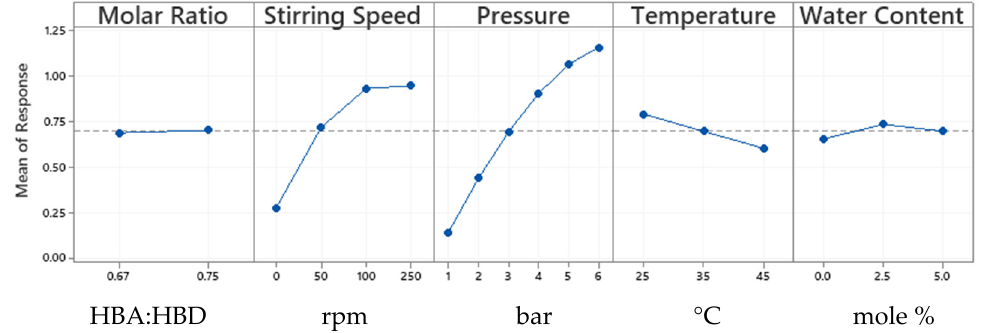
Figure 6. Main effects plot for CO 2 absorption in ChCl:LvAc DESs. The second-order and higher interactions of factors have a very small contribution to the model. More details are available in the supplementary information document in Sections